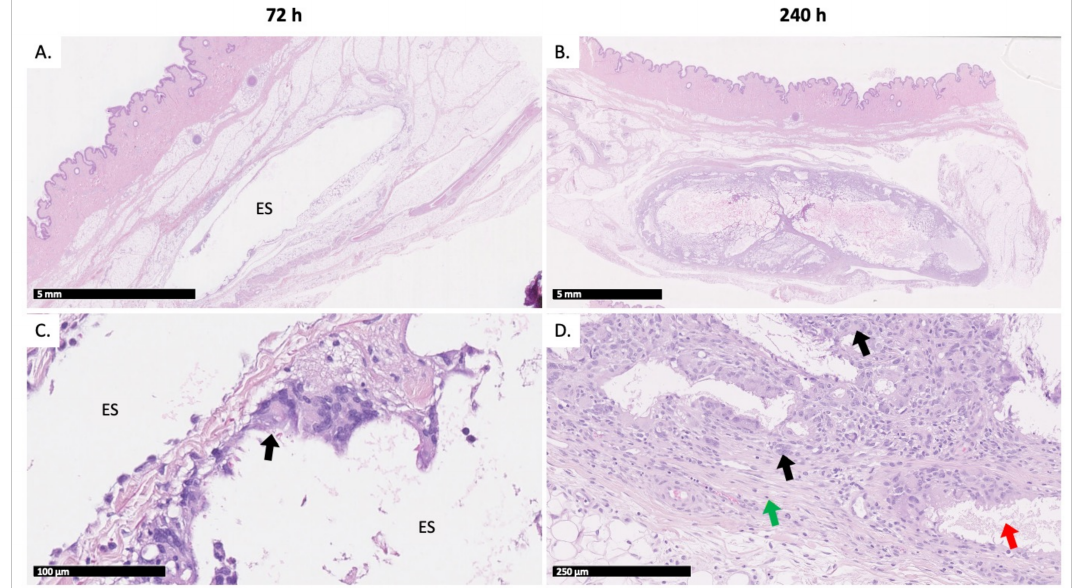
Figure 4. Representative H&E histopathology of injection sites: ( A ) test item injection site at 72 h and ( B ) test item injection site at 240 h. A focus on the fibrous capsule is presented ( C ) at 72 h, and ( D ) at 240 h. ES: poorly defined empty spaces in the subcutis. Green arrow: fibrous capsule. Black arrow: inflammatory cells, including multinucleated macrophages. Red arrow: empty spaces.